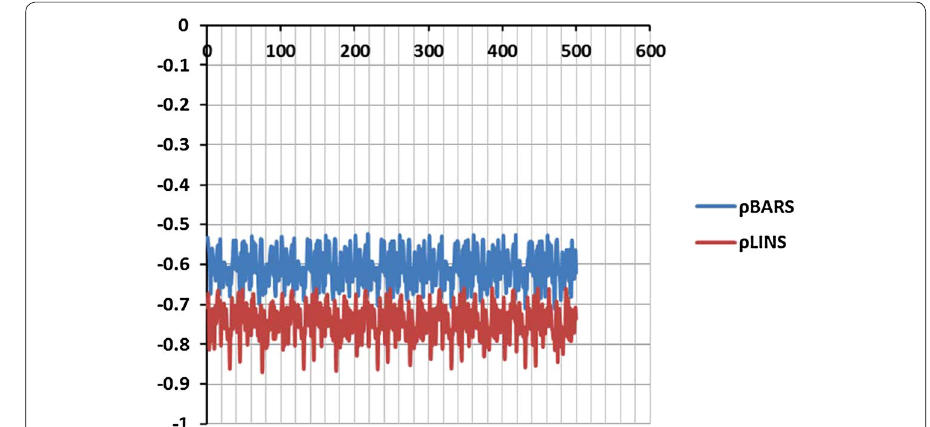
Fig. 3 Modification of the ratios ρ BARS and ρ LINS